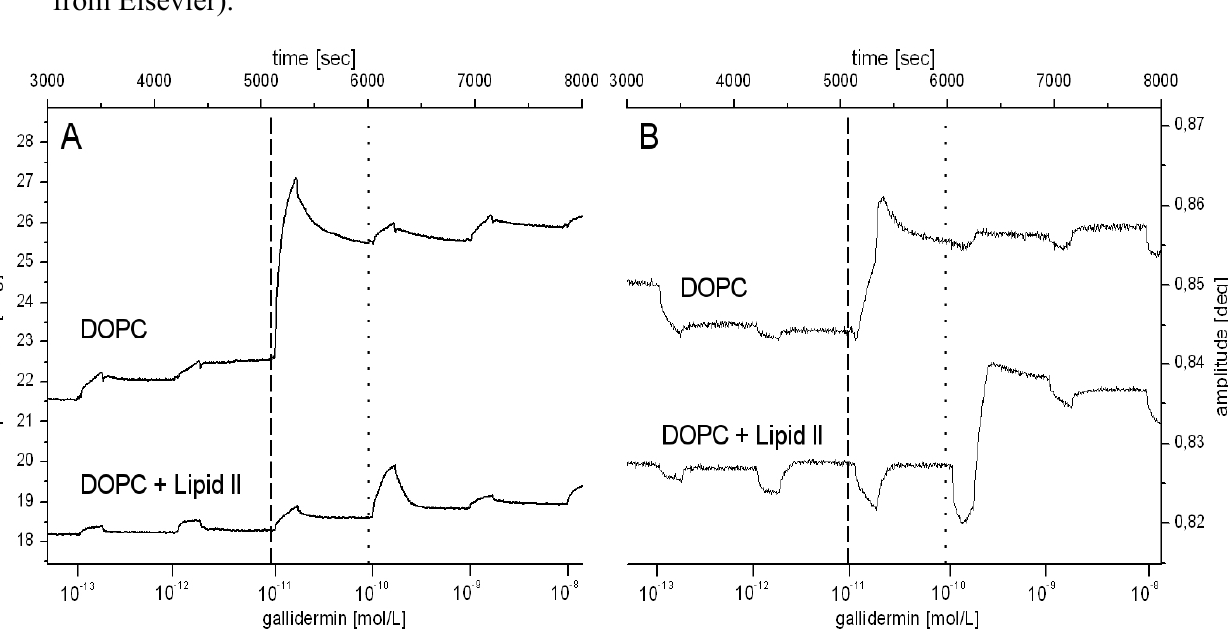
Figure 5. Illustration of SAW measurements. The changes in phase ( A ) and amplitude ( B ) of surface acoustic waves confirmed the lipid II recognition (dotted line in (A)) in parallel to gallidermin membrane insertion and a resulting membrane rigidification (increase in amplitude in (B) at the dashed or dotted line, resp.) (reprinted with permission from Al- Kaddah, S.; Reder-Christ, K.; Klocek, G.; Wiedemann, I.; Brunschweiger, M.; Bendas, G. Analysis of membrane interactions of antibiotic peptides using ITC and biosensor measurements. Biophys. Chem. 2010 , 152 , 145-152. Copyright © 2010, with permission from